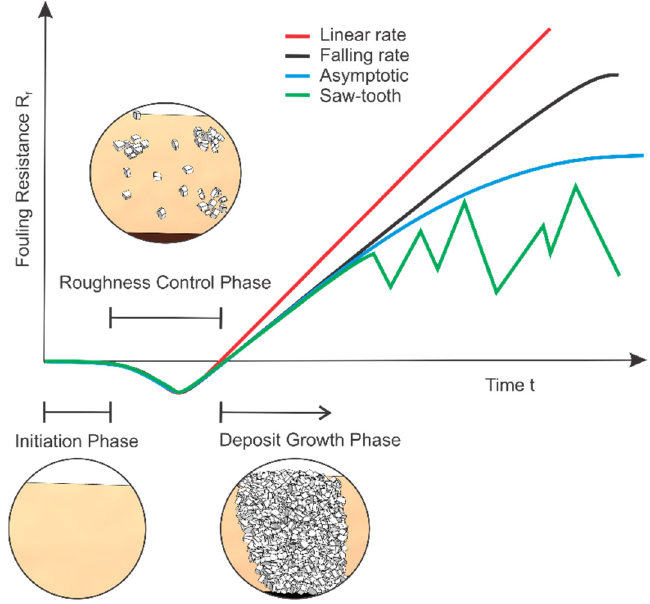
Figure 2. Typical fouling resistance curves.